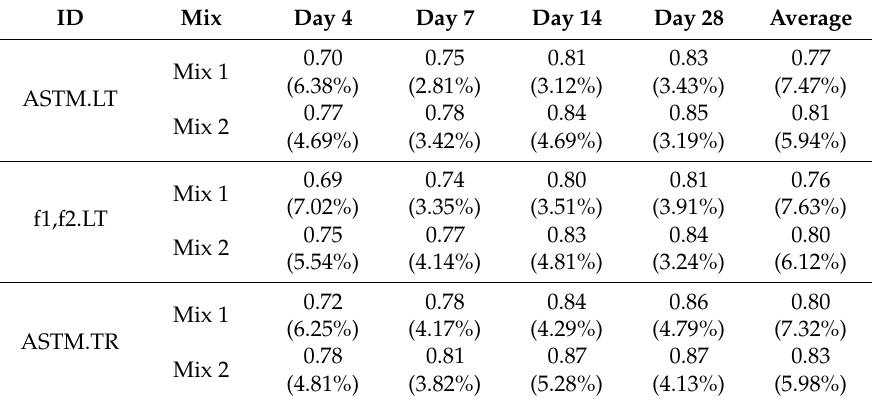
Figure 9. Comparison of first frequency of LT mode and E-modulus. Table 6. Correction factors and MAPE for ages and mixes between Ed and Ei.